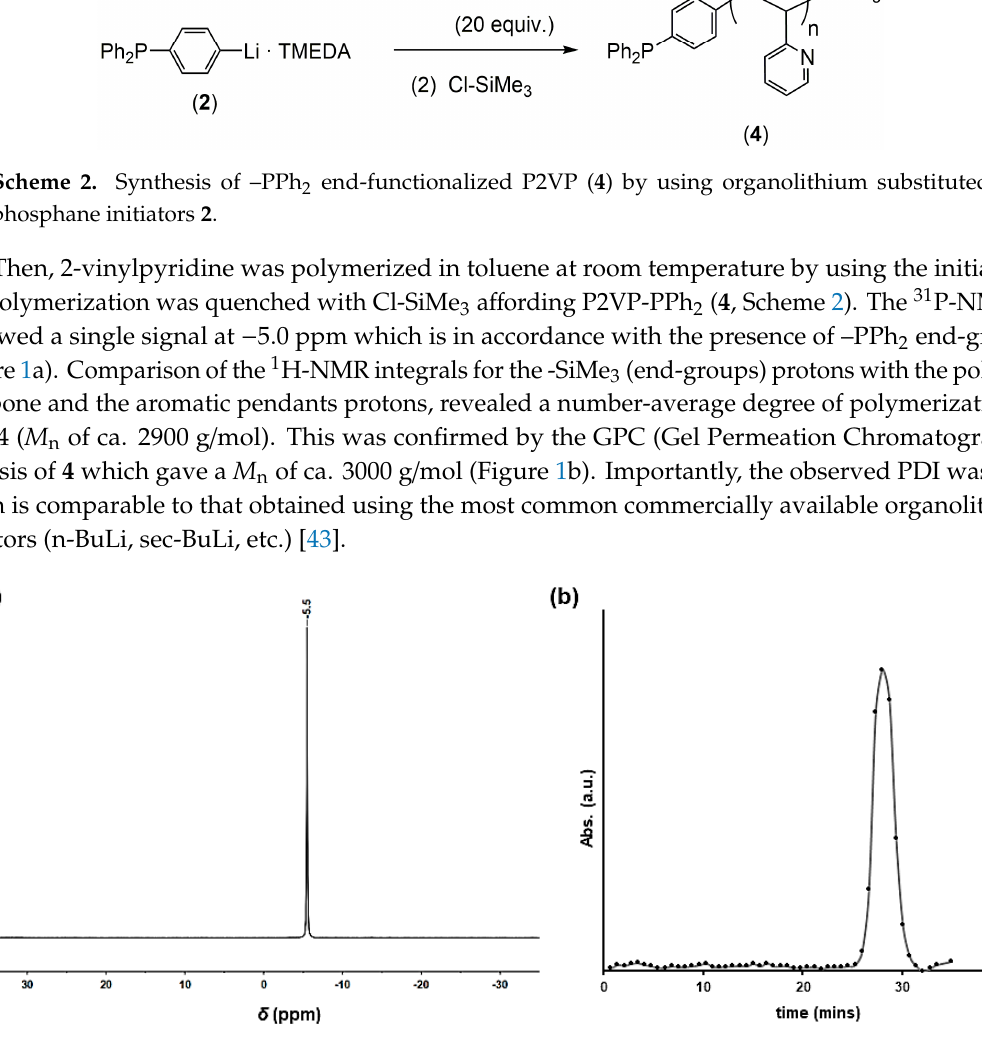
Figure 1. ( a ) 31 P-NMP and ( b ) UV-GPC (Gel Permeation Chromatography with UV-vis detector) trace of polymer 4 (P2VP-PPh 2 ).